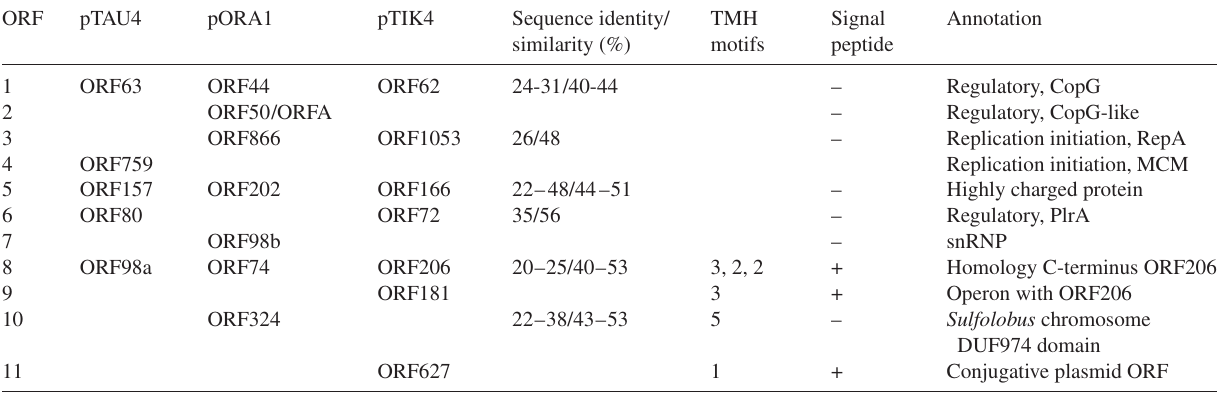
Table 1. Open reading frame (ORF) analysis of the plasmids pTAU4, pORA1 and pTIK4. Transmembrane spanning helices (TMH) were pre- dicted with TMHMM and signal peptides were predicted by Signal-P